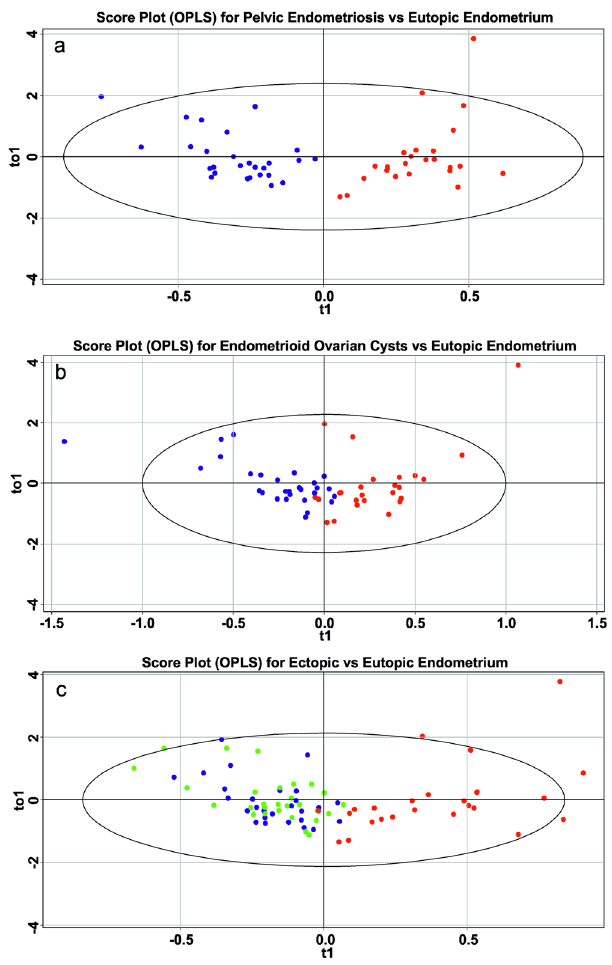
Figure 5. Score plots of multivariate data analysis of relative abundances of ions in negative ion mode using the OPLS-DA method ( a ) pelvic endometriosis vs eutopic endometrium; ( b ) endometriotic ovarian cysts vs eutopic endometrium; ( c ) ectopic vs eutopic